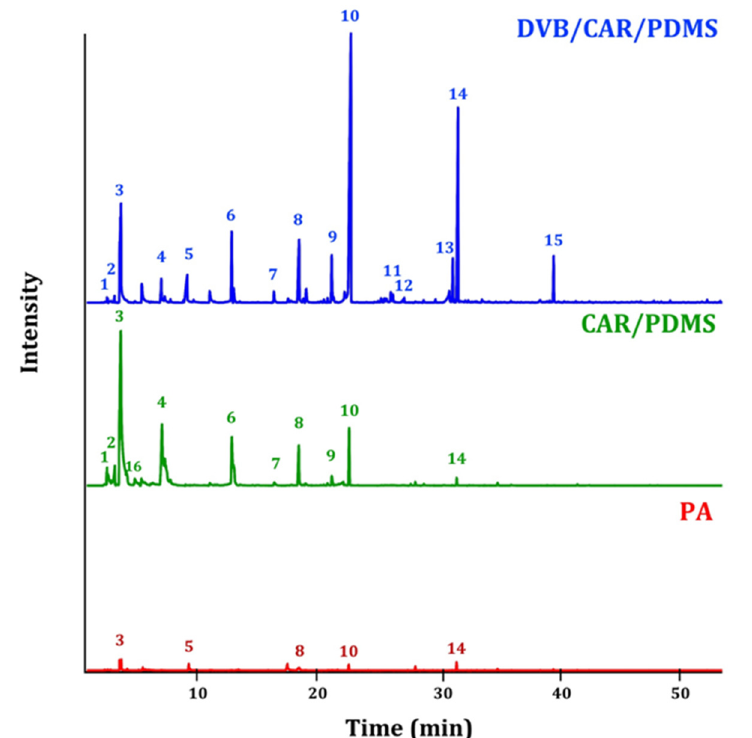
Figure 2. Overlaid chromatograms of a single cider sample (EsoTerra Cider) analyzed with 3 different Figure 2. solid phase microextraction (SPME) fibers are shown. Red),